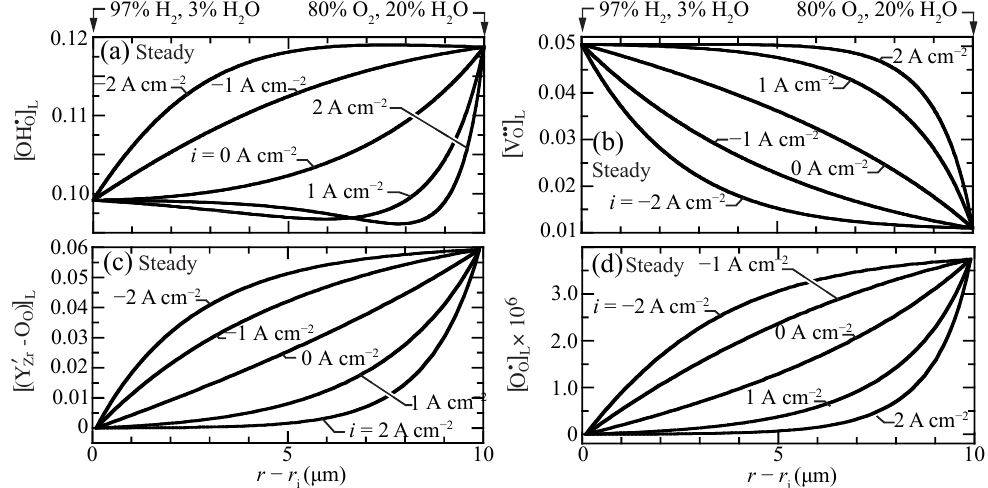
Figure 2. Charged-defect concentration profiles (lattice units) across the membrane for imposed current densities ( i = − 2, − 1,0,1,2 A cm − 2 ) at 600 ◦ C. ( a ) protons, ( b ) oxygen vacancies, ( c ) trapped polarons, and ( d ) O-site